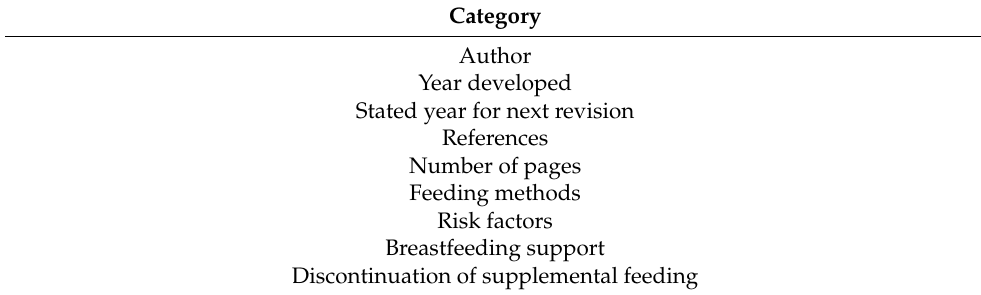
Table 1. The nine